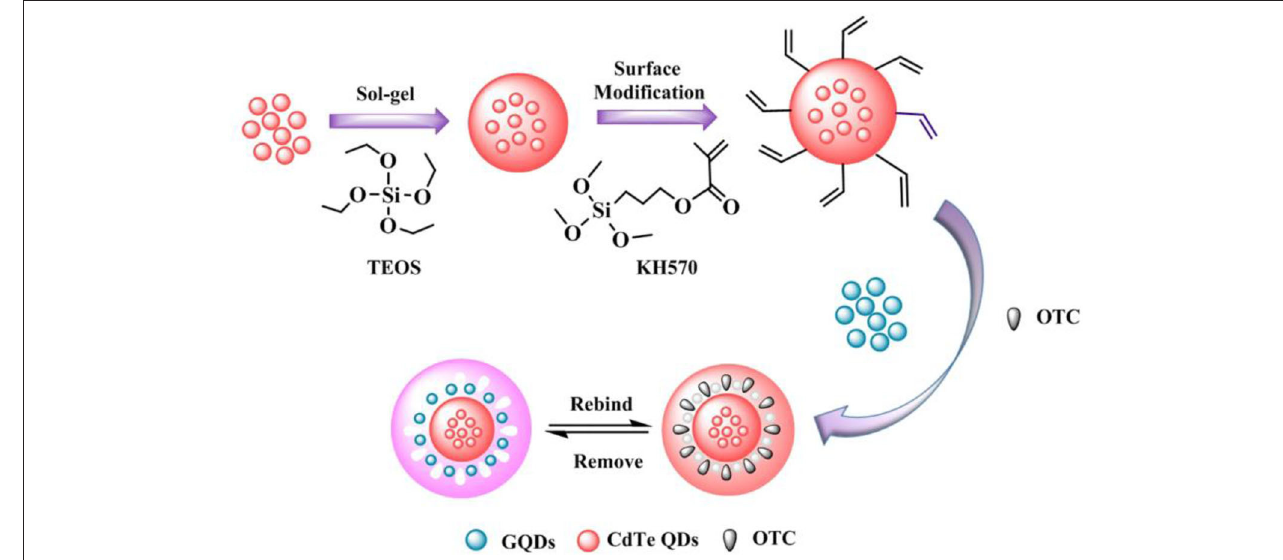
FIGURE 11 | The synthesis process of GQDs/CdTe@MIPs (Wang et al., 2020). Reprinted with permission from Elsevier. Copyright (2020) Elsevier.